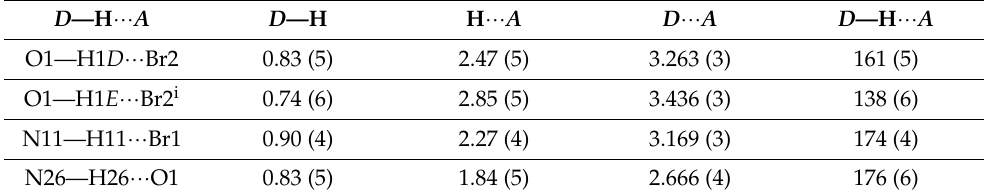
Figure 7. The crystal packing of 1 , viewed along the a-axis, where a, b and c denote unit cell axes.